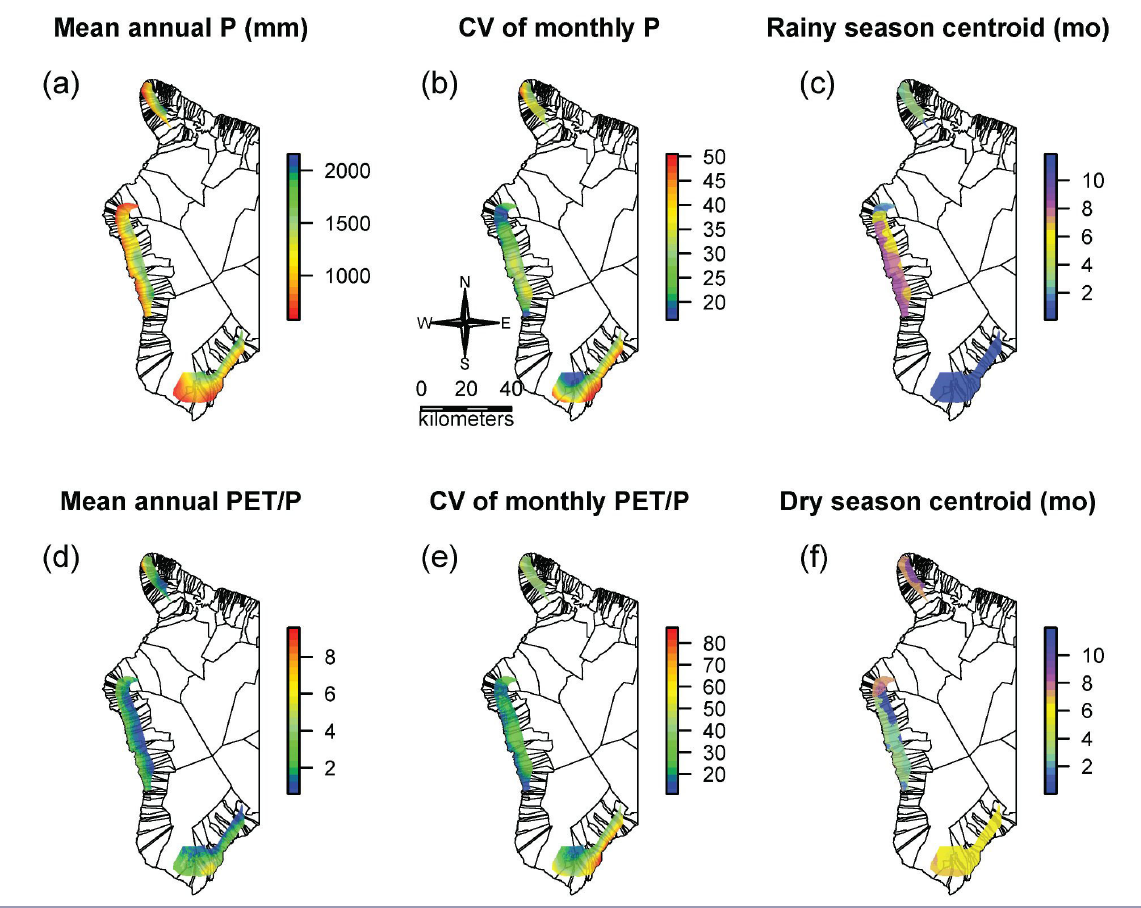
Fig. 3 . Spatial variability in rainfall in terms of (a) mean annual value, (b) coefficient of variation (CV, %) across 12 months as an index of seasonality, (c) rainy season centroid from 0–12 with January as 0–1. Spatial